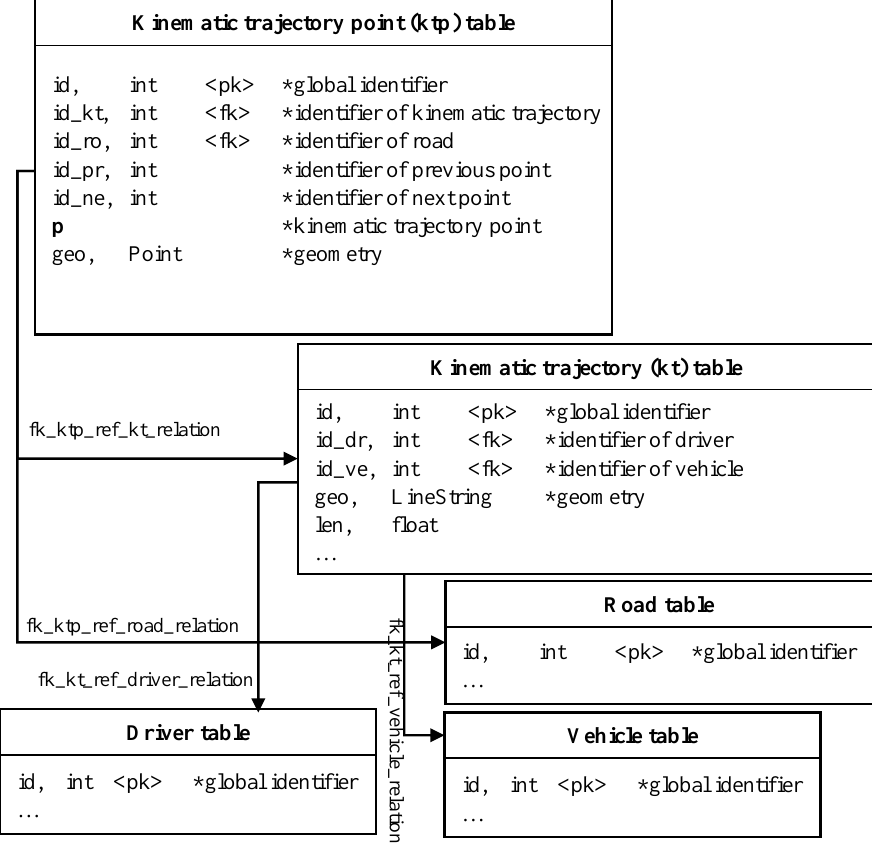
Figure 2. The physical data model of spatial kinematic trajectory database, where * denotes explana- tions of the